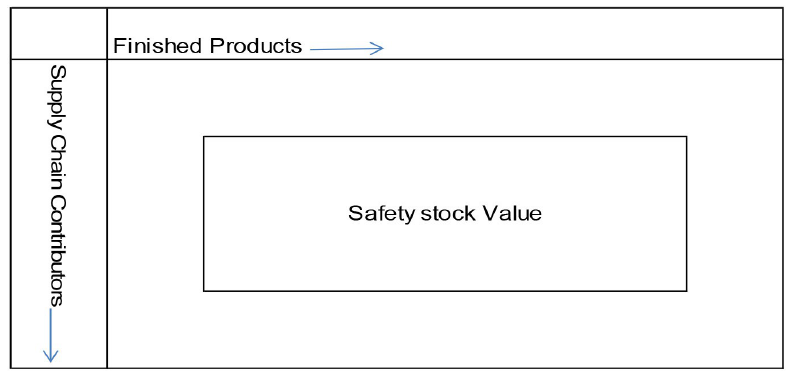
Table 4. Safety stock distribution pivot table template